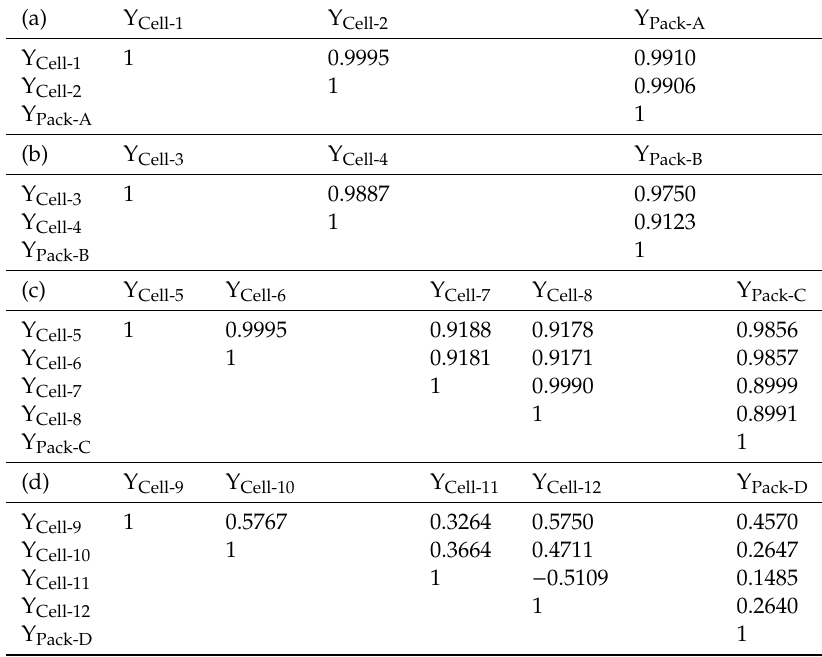
Table 5. Pearson correlation matrix for capacity degradation in (a) Pack A; (b) Pack B; (c) Pack C; (d) Pack